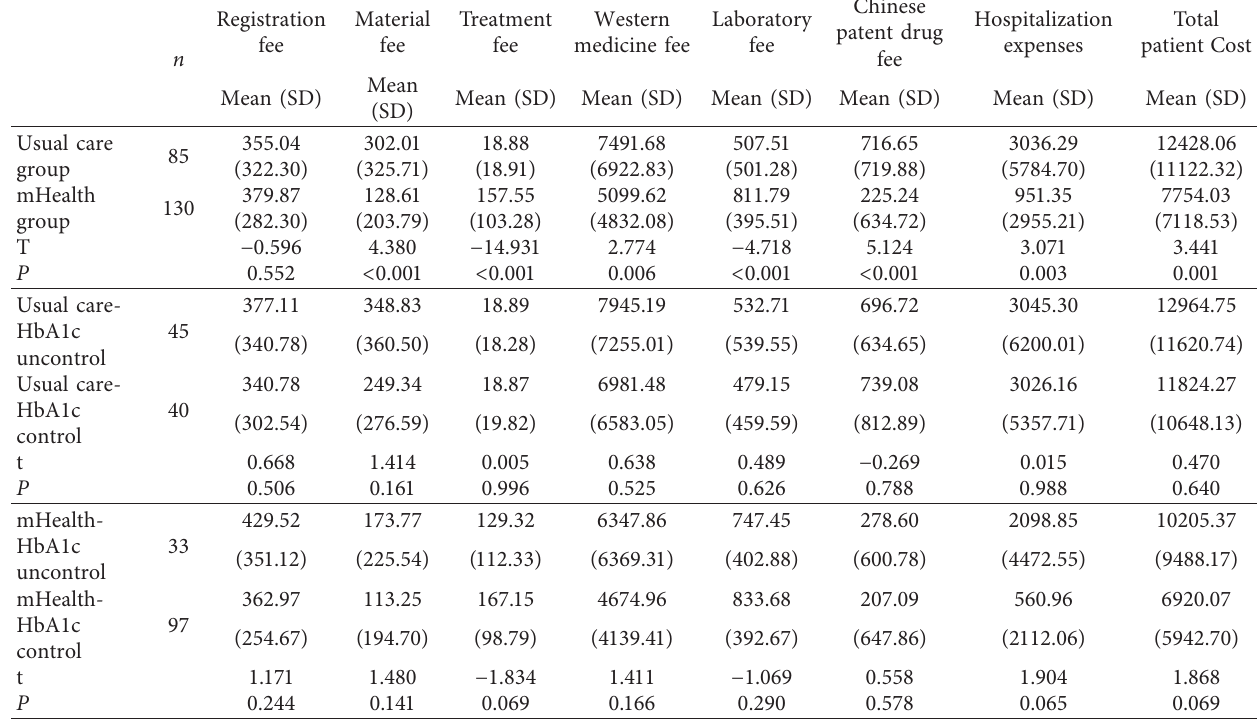
Table 1: Cost comparison between the mHealth group and usual care group at 12-month follow-up (CNY¥).